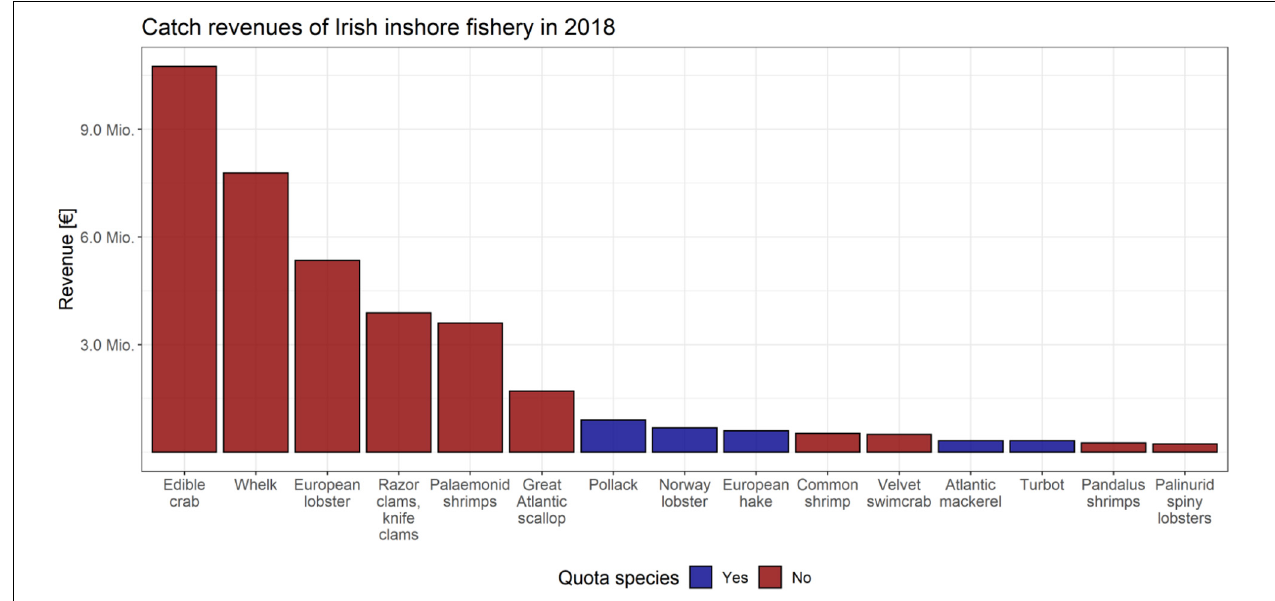
FIGURE 4 | Cumulated revenues of Irish inshore fisheries per species for 2018. Revenues are given in million €; species are ranked by the total revenue in descending order. Only the 15 most important target species accounting for 95% of the total revenue, are displayed. All data taken from STECF (2020).